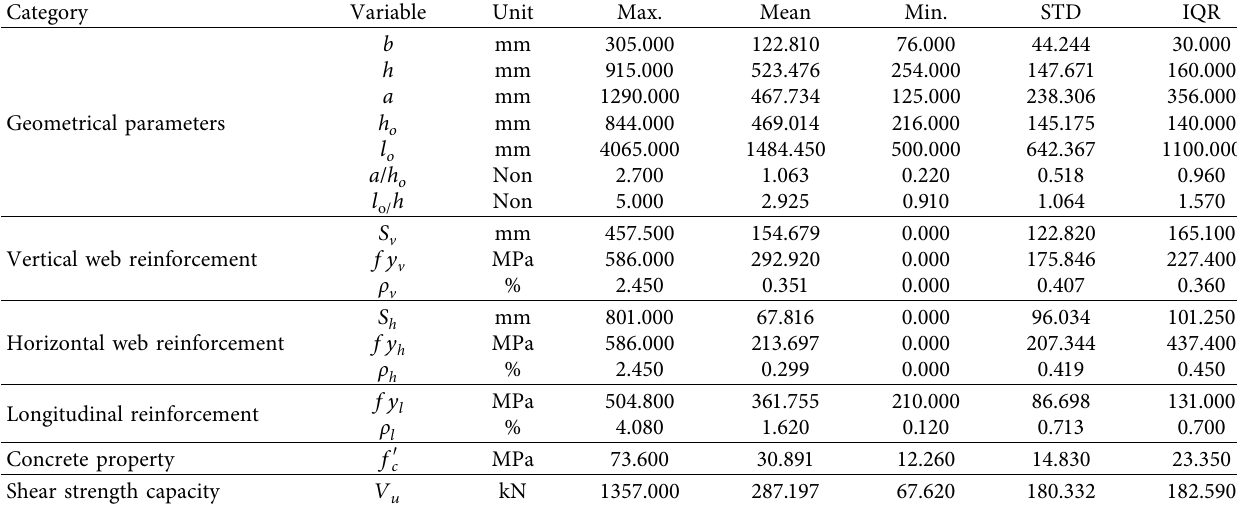
Table 2: The statistical description of the input parameters used in this study. Category